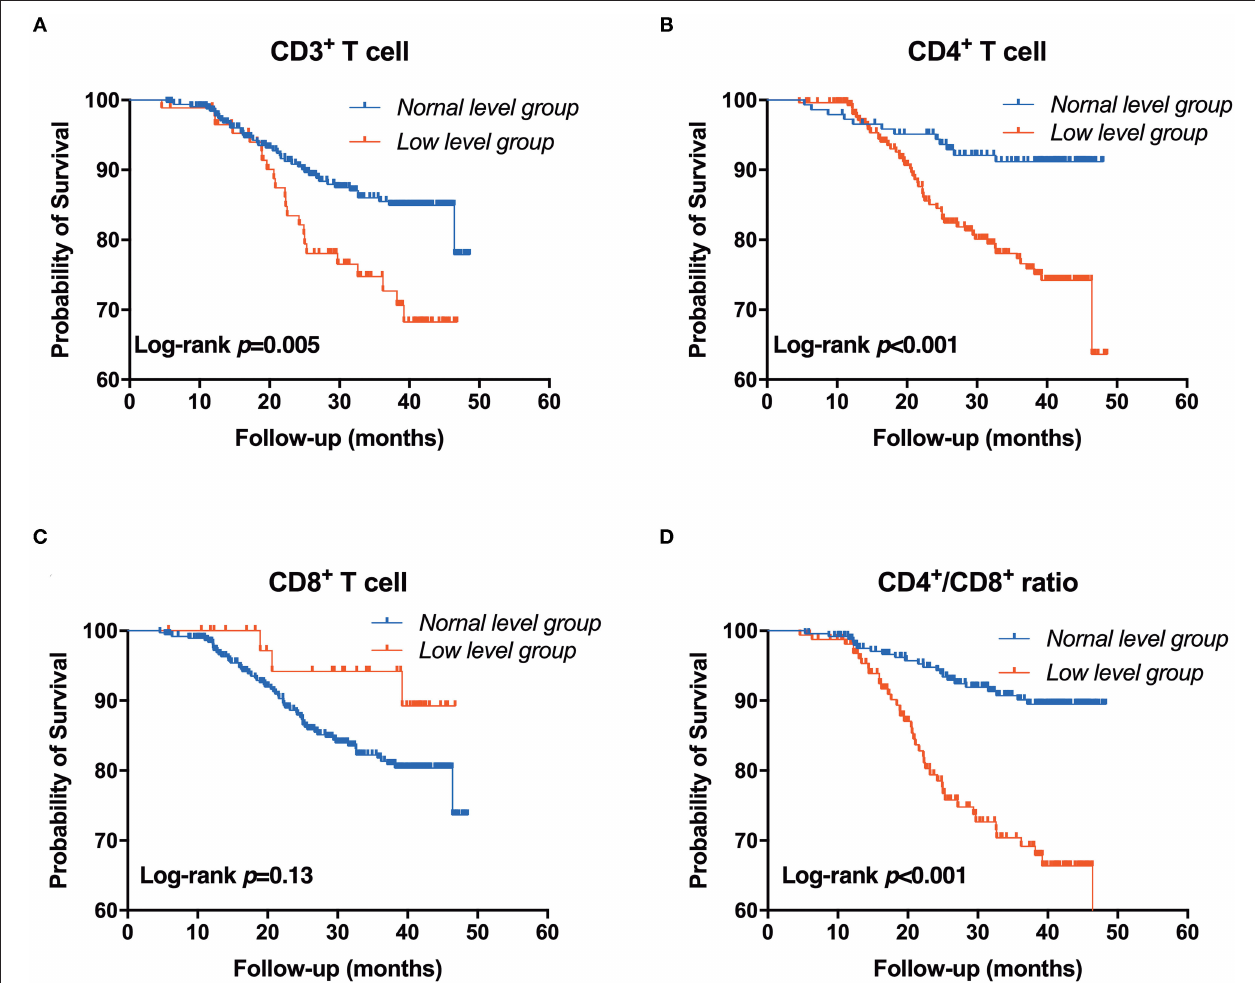
FIGURE 2 | Association between T-lymphocyte subsets and major infection. (A) CD3 + T cell, (B) CD4 + T cell, (C) CD8 + T cell, (D) CD4 + /CD8 + T cell. Patients were stratified into two groups by clinical reference value (Kaplan-Meier analysis with log-rank test).